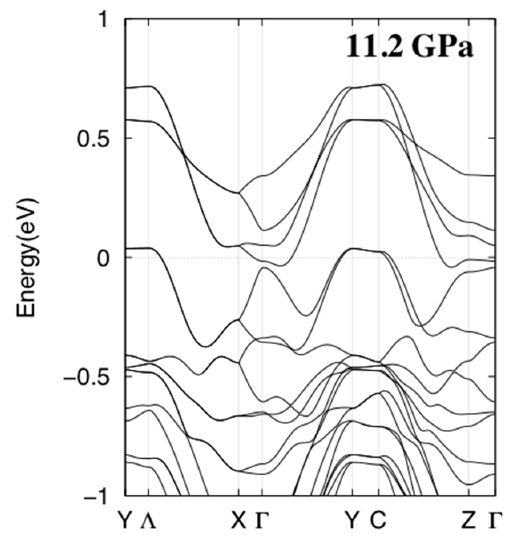
Figure A2. Band structure calculated from first principles DFT for the experimentally-determined structure at 11.2 GPa.